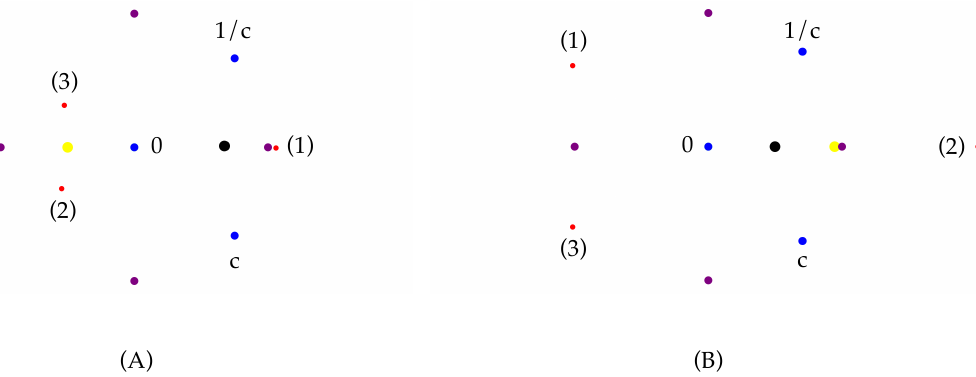
Figure 18: Manipulate environment in Mathematica . The purple dots are added by hand, fixed and give a frame of reference. The yellow dot sets the value of α and moves in a parameter plane. The blue dots give the location of the branch points in dependence of α and live on the t -plane. The black dot determines a value for t in the t -plane. The red dots are the three sheets v ( t ) for given t and move in the cotangent plane of the Gaiotto curve. The yellow and black dot can be dragged using the cursor. The black dot is to be dragged along the paths γ . The subfigure labelled (A) and i (B) give the v -curve with discriminant factors ( t − 1 ) 2 and ( t + 1 ) 2 respectively. The numbers in brackets are attached to the red dots and give a labelling of the three sheets in a neighbourhood of t = 1 / 2. The labels c ,1 / c mark the location of the branch points. The singularities are at t = 0, ∞ of which the first is